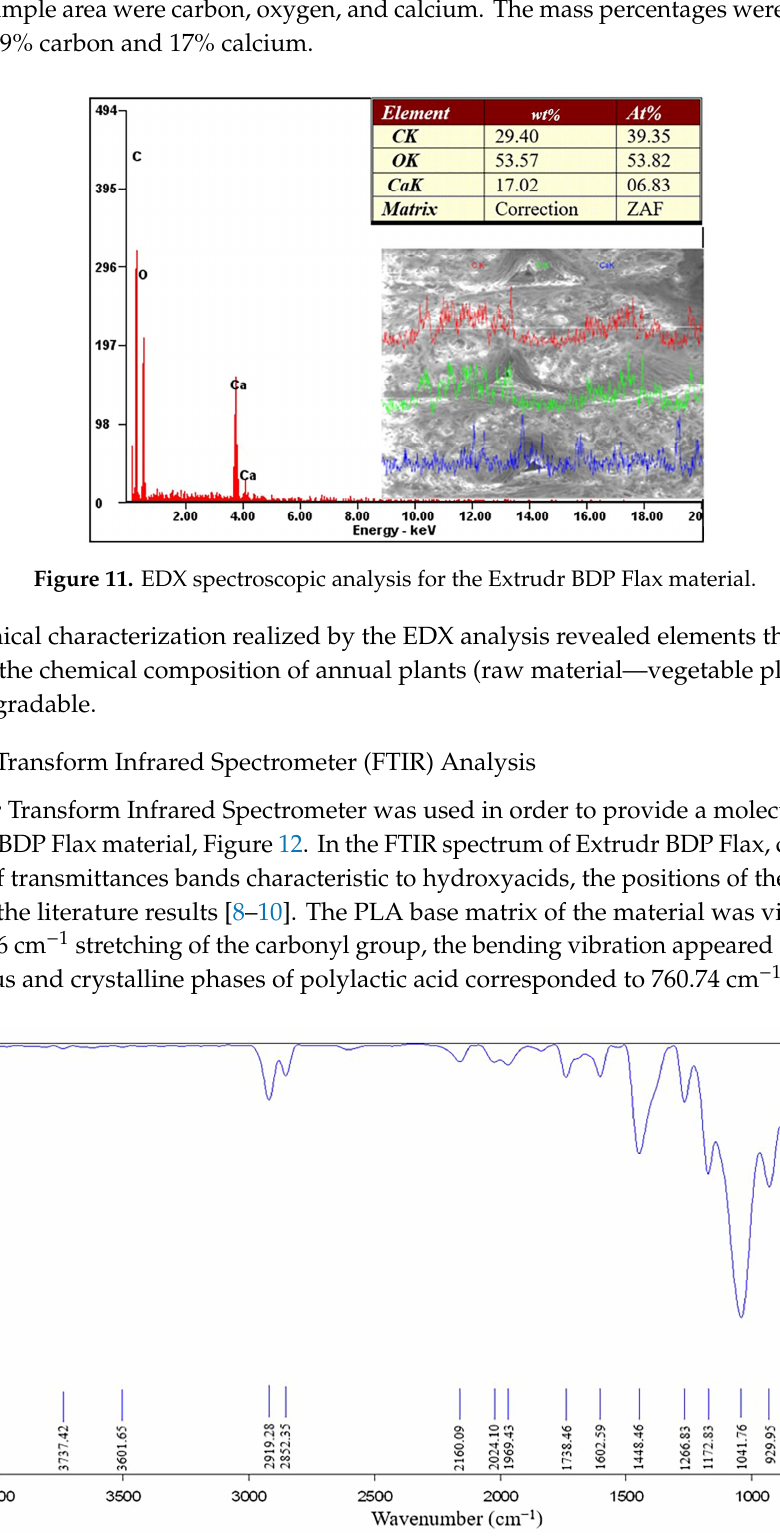
Figure 12. FTIR spectrum of the Extrudr BDP Flax material.